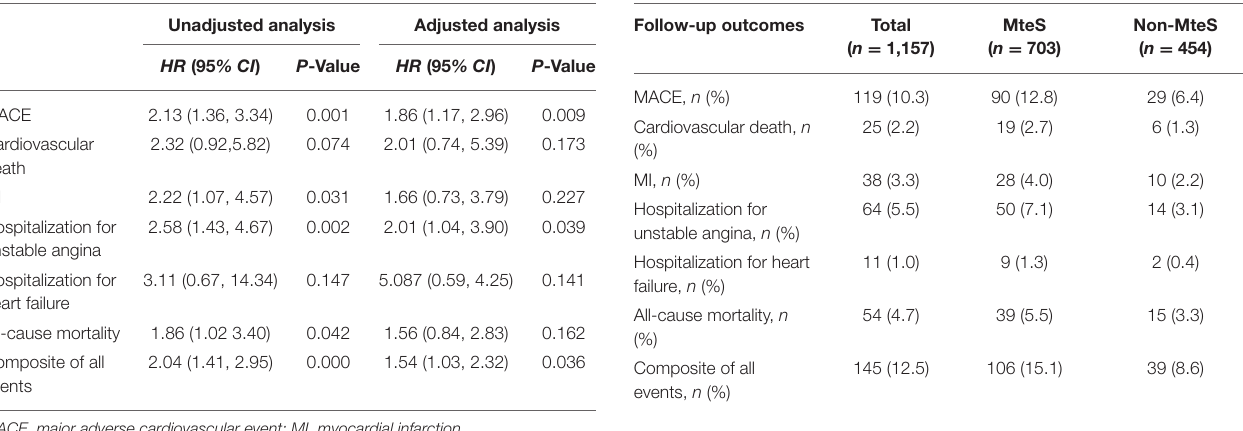
TABLE 4 | Crude number of adverse events during follow-up.